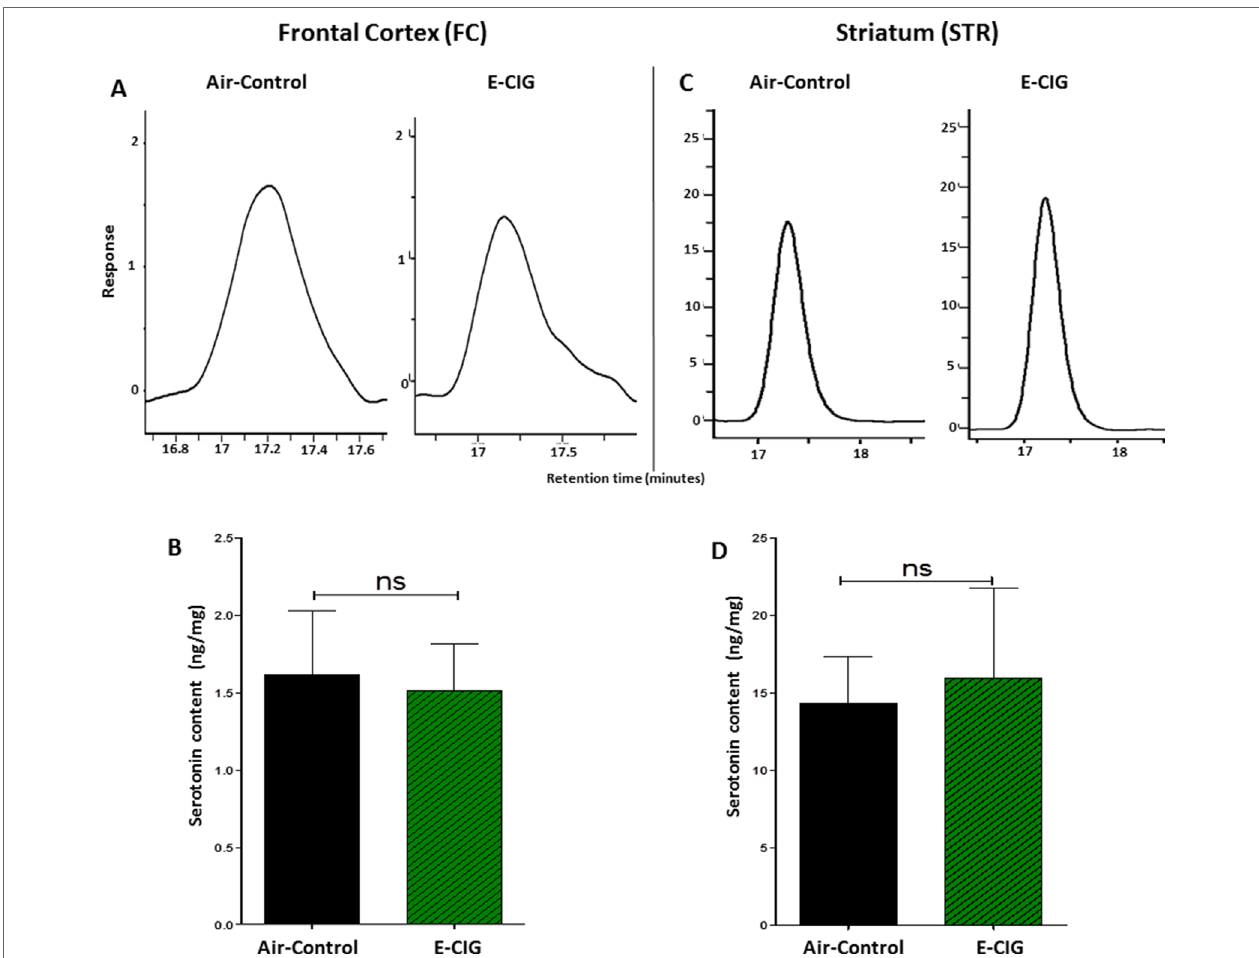
FIGURE 2 | Effect of inhalation of E-CIG for 6 months on serotonin concentrations in the FC and STR in male C57BL/6 mice. (A) Peaks of serotonin in the FC in air controls and E-CIG groups. (B) Independent t -test analysis did not show any significant alterations in serotonin concentration in the FC between E-CIG and air controls. (C) Peaks of serotonin in the STR in air controls and E-CIG groups. (D) Independent t -test analysis did not reveal any significant alterations in serotonin concentration in the STR between E-CIG and air controls. Data are reported as mean ± SEM (ns, not significant), ( n = 5 for each group), ( X -axis, retention time [minutes], Y -axis,